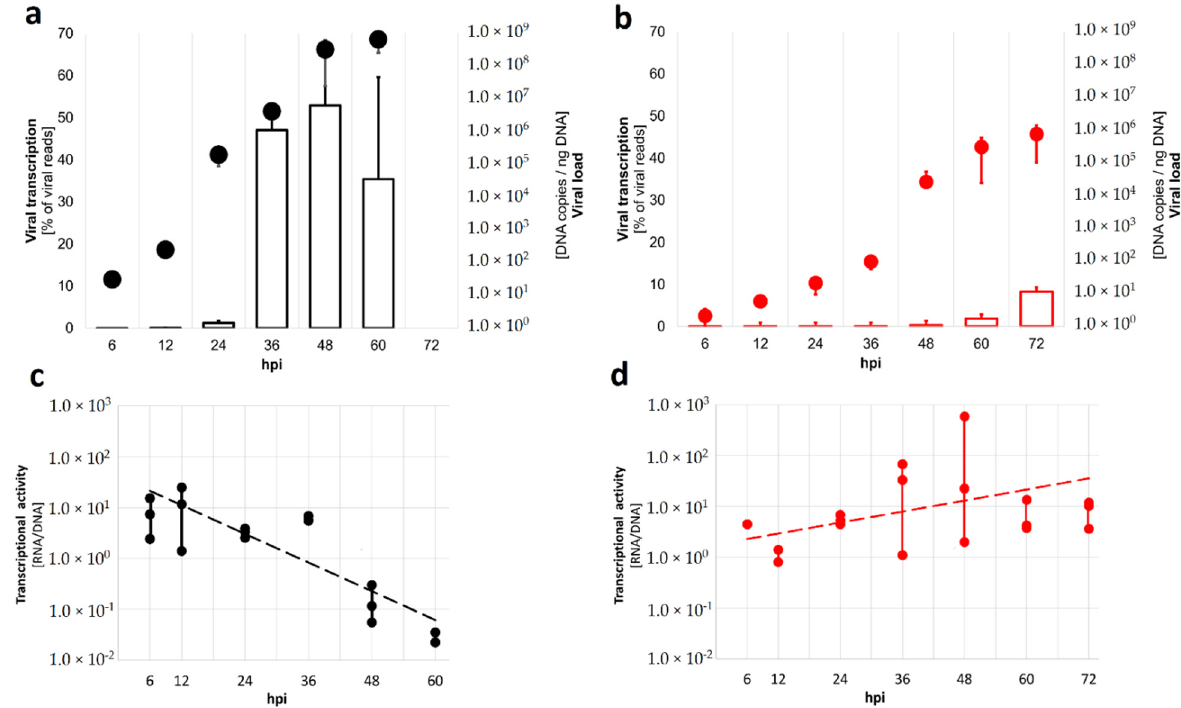
Figure 1. Malacoherpesvirus replication and transcription dynamics. The proportion of viral reads over total reads (viral transcription empty bars) and the viral replication measured by viral copies per ng of total DNA (viral load, dots referring to the secondary axis) are reported for HaHV-1 (black) ( a ) and OsHV-1 (red) challenges ( b ). The normalized transcriptional activity (i.e., the average virion transcription) expressed as the ratio of viral RNA over DNA showed distinct dynamics for both viruses with activity decreasing in HaHV-1 ( c ), while it was increasing for OsHV-1 ( d ) (ANOVA time × virus interaction F 1,9 = 5.353, p = 0.046).